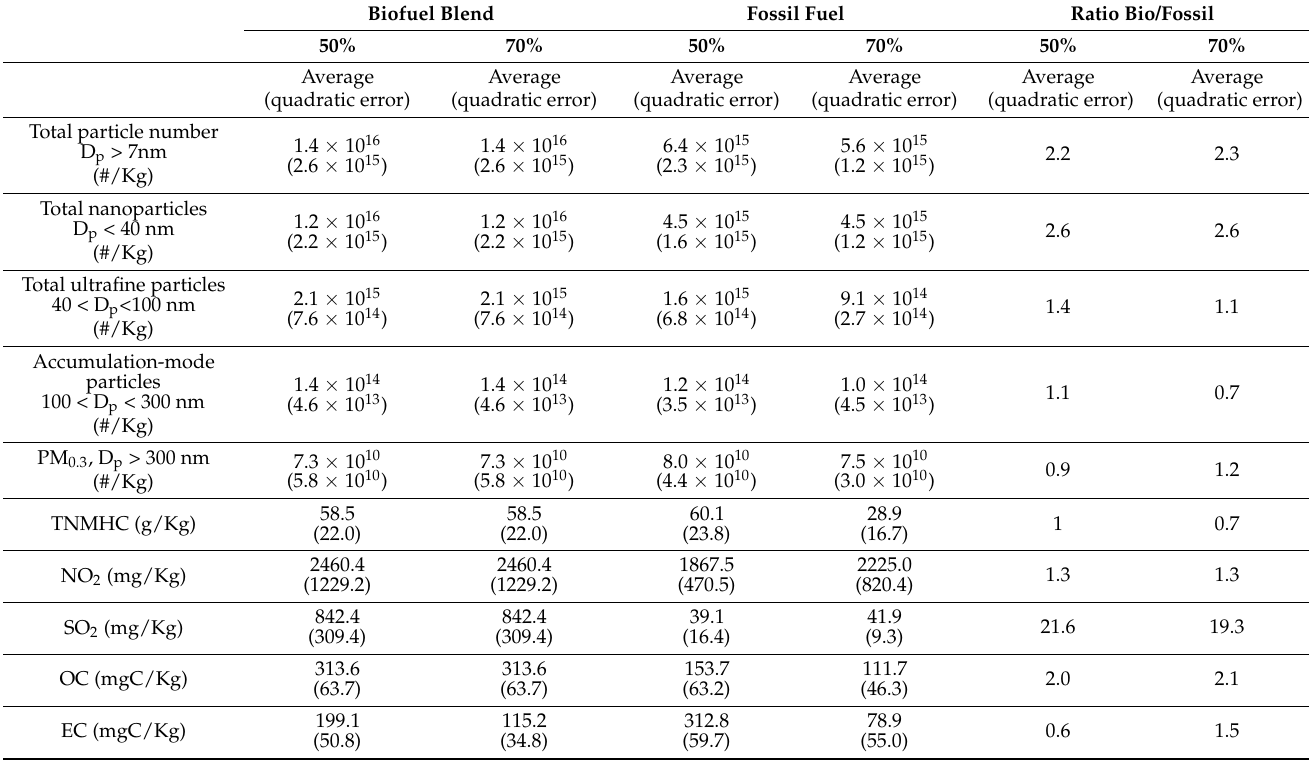
Table 7. Emission indexes calculated per kg of fuel consumed during each test, grouping the experiments with thrust equal to 50% and with thrust equal to